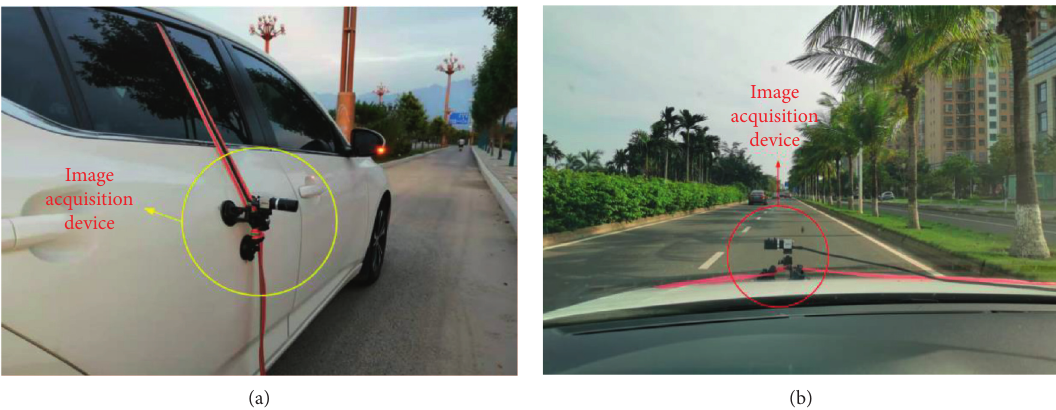
Figure 10: (a) The image acquisition device that is installed on the side of the vehicle. (b) The image acquisition device that is installed on the hood of the